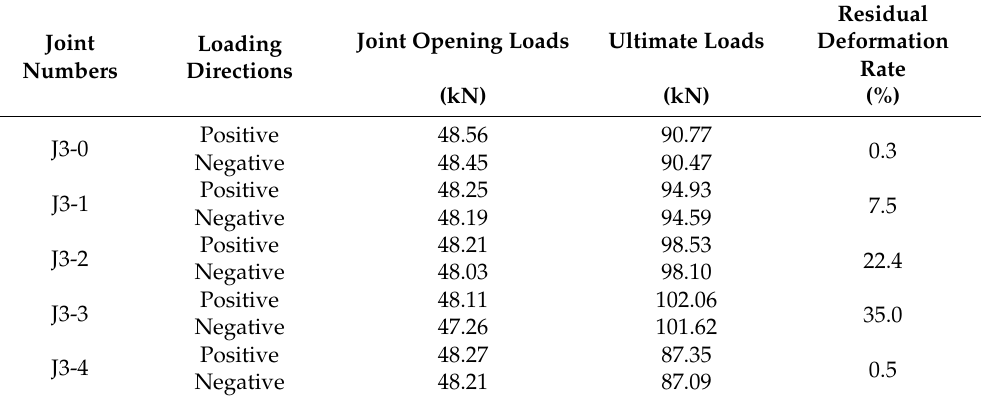
Table 8. Key data of joint load–displacement curves.